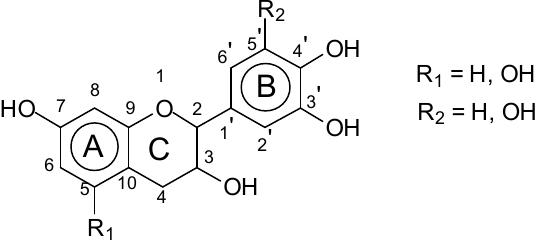
Figure 1. Basic structure of a condensed tannin flavonoid unit.